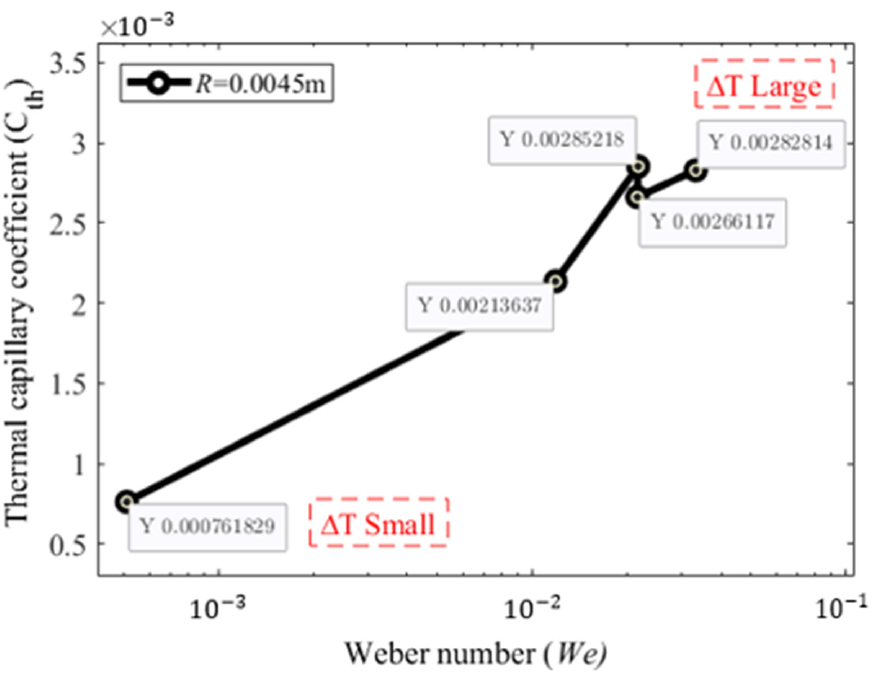
Figure 11. Thermo-capillary coefficient ( C Th ) vs. the Weber number ( We ) for R = 0.0045 m. For bubble sizes in the range of 0.008 m ≤ R < 0.01 m, Figure 12 shows the thermo- capillary coefficient ( C Th ) vs. the Weber number ( We ) for R = 0.008 m. It is found that the temperature difference ∆ T does not affect the Weber number much. However, the thermo-capillary coefficient decreases when ∆ T increases except for ∆ T = 20 K.